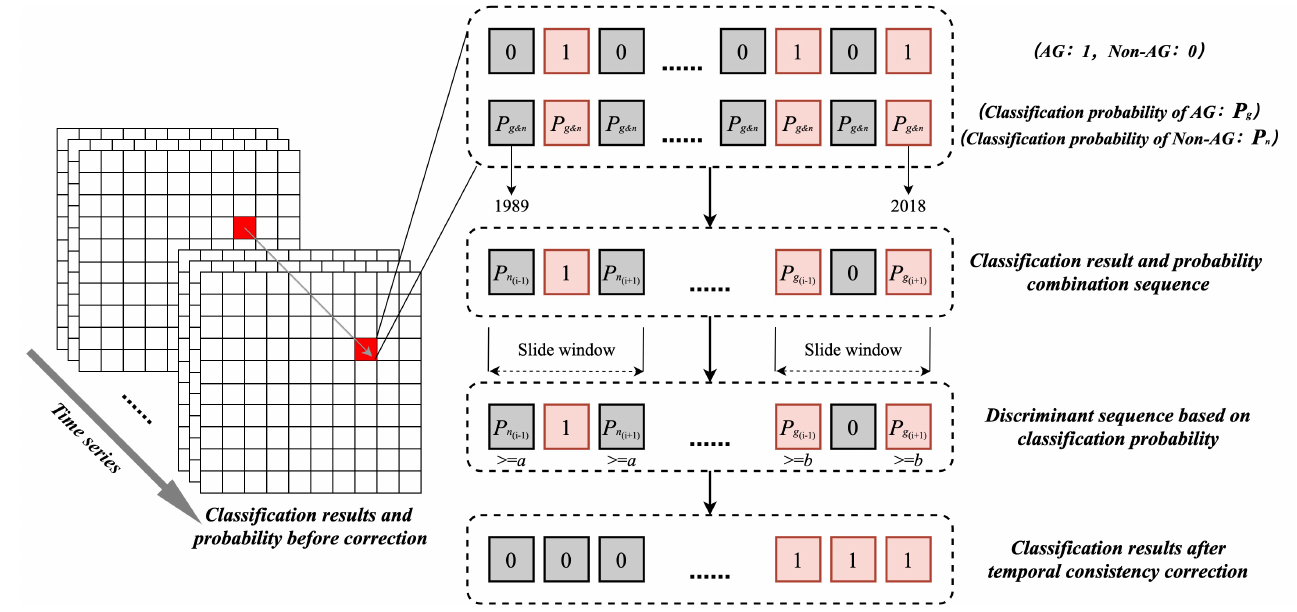
Figure 8. Detailed procedures of the PTCC